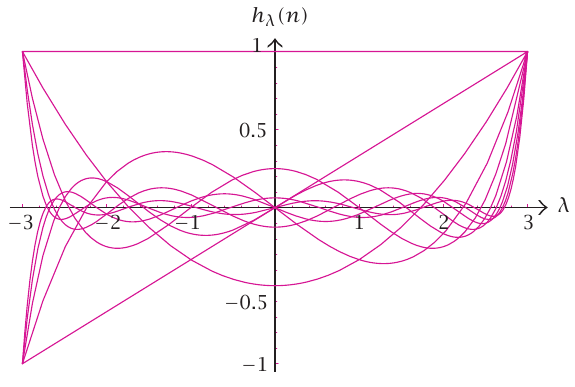
= 0 , 1 ,..., 9 , for the λ (n), n